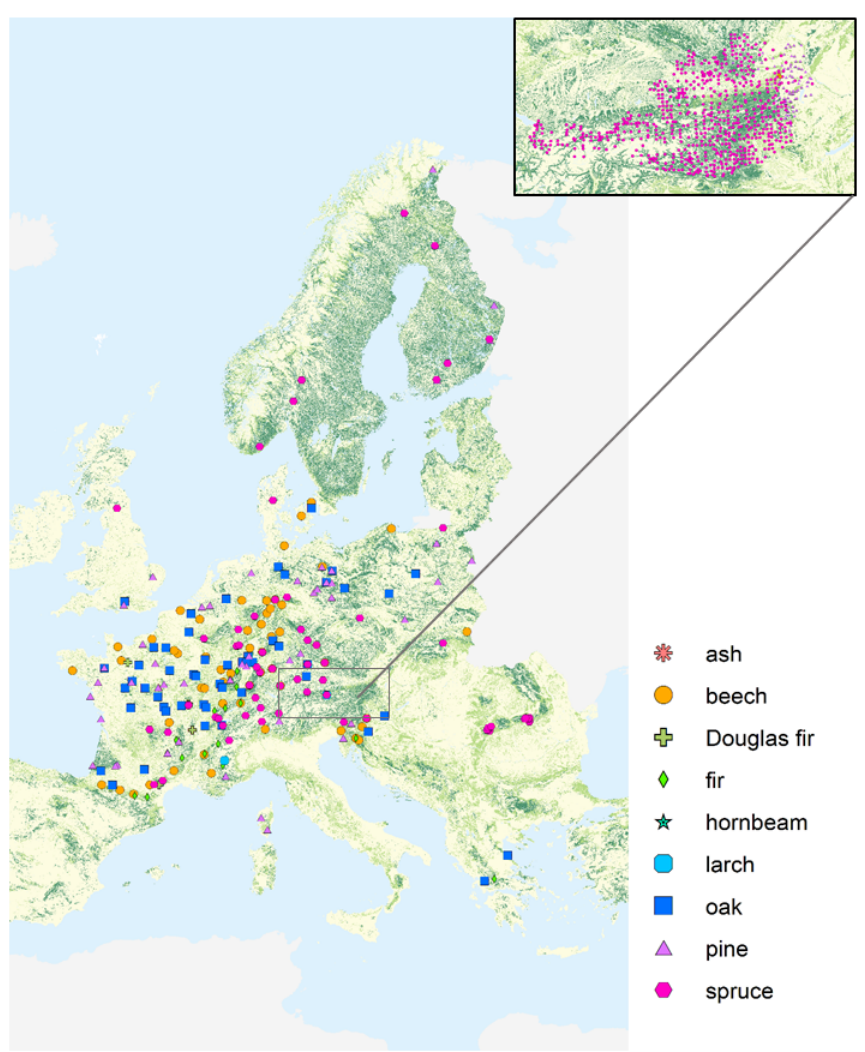
Figure 1. Overview of forest plots at which Hg foliage samples were harvested from different tree species groups during the sampling year 2017. At around 12% of plots in 2017, foliage from more than one tree species group was sampled. Geographic distribution of sampling sites in 2015 is similar, except there were no samples from the ICP Forests partners Brandenburg (Germany), Baden-Württemberg (Germany), and Poland, and there were samples from five additional plots in North Rhine-Westphalia (Germany); see Fig. S1 in the Supplement. The enlarged map view at the top right depicts sampling locations of the Austrian Bio-Indicator Grid in 2015 and 2017. Use of base map authorized under European Commission reuse policy (EU,